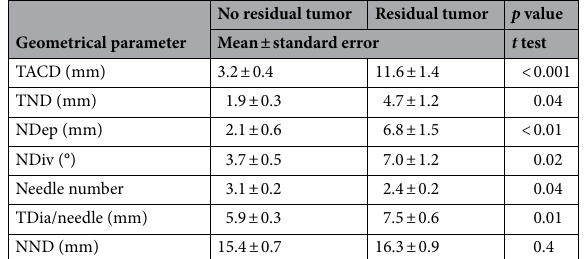
Table 2. Geometrical parameters measured in both groups. For the abbreviations and visual explanation of the parameters see Fig. 1.